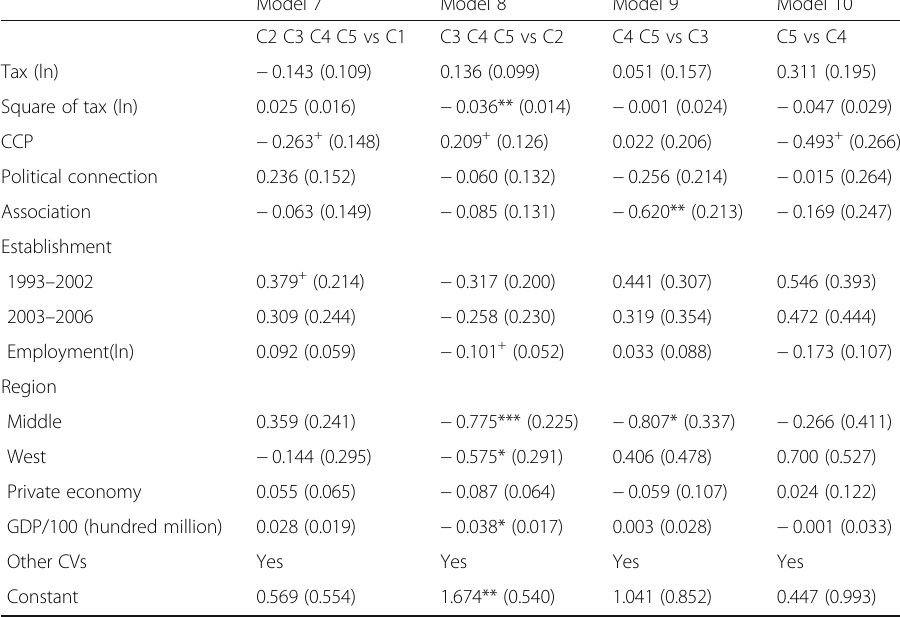
Table 6 Seqlogit models predicting strategy selection ( N =